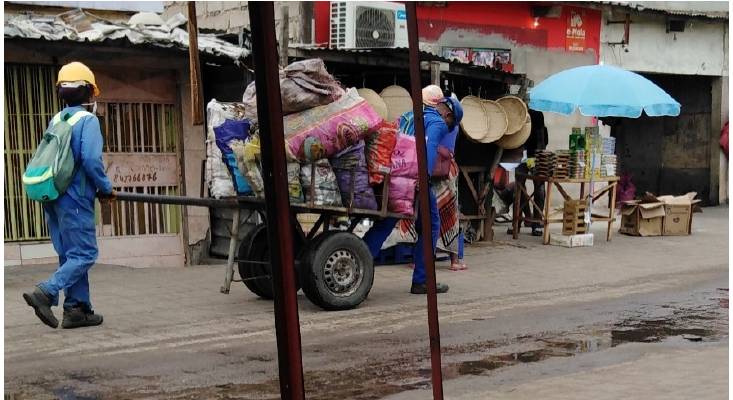
Figure 9. Garbage collection inside Benfica’s market to dump in the large containers outside the market, before opening.